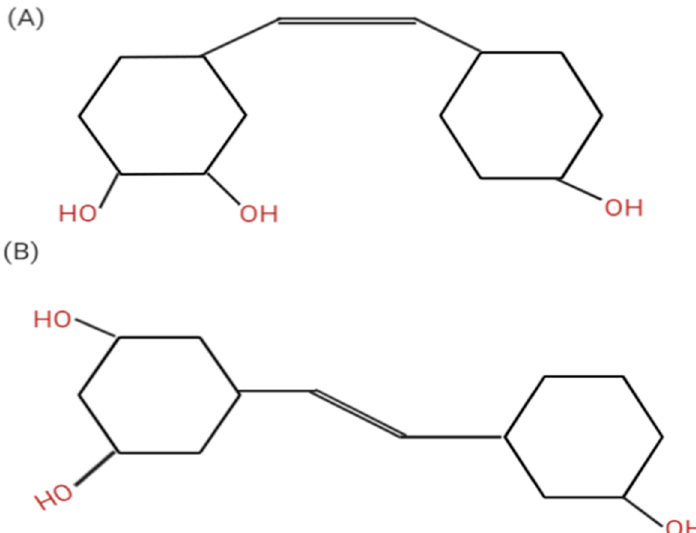
Figure 1. Resveratrol chemical structure in cis ( A ) and trans ( B ) isoforms. Trans is the biologically active form. Created using Biorender software.